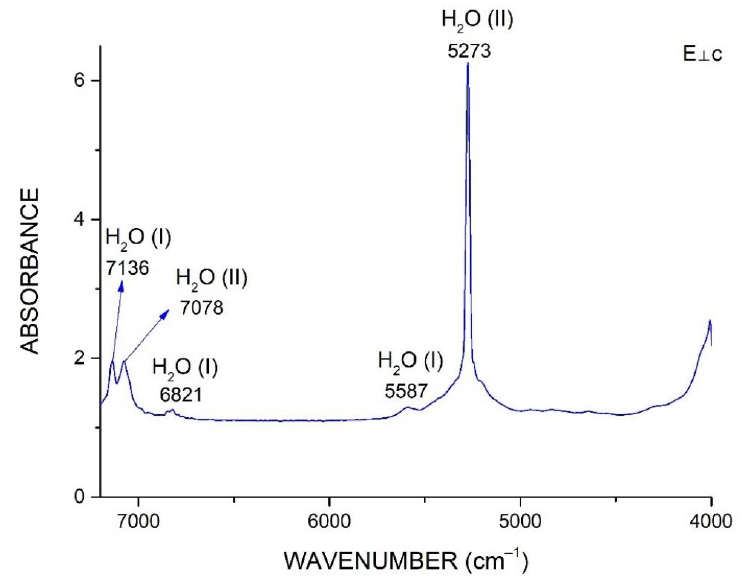
Figure 13. The representative FTIR spectrum in the range of 7200 – 4000 cm −1 (E ⊥ C) illustrating type I and type II H 2 O observed in Indian emeralds.